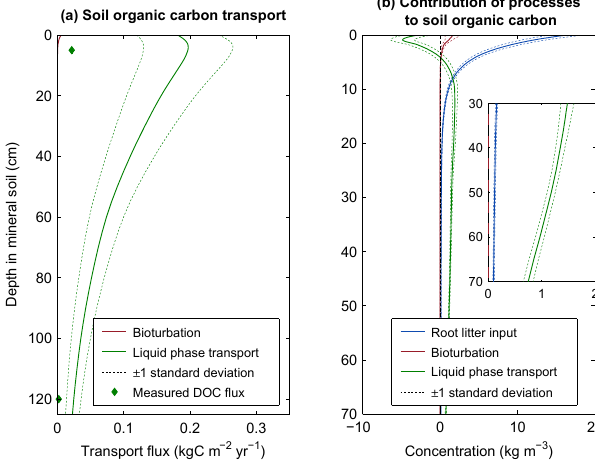
Fig. 5. Organic carbon measurements and corresponding model re- sults of forward Monte Carlo simulations for Loobos, based on pos- terior distribution of calibration setup 3. (a) Stocks and fractions of the model pools; (b) above- vs. belowground derived organic mat- ter. L, F, and H refer to the organic horizons (see Sect. 2.1); topsoil: 0–30cm; subsoil: > 30cm; OM: organic matter. All model results are averages over the Monte Carlo ensemble; error bars denote one standard error of the mean for the measurements and one standard deviation (SD) for the model results.